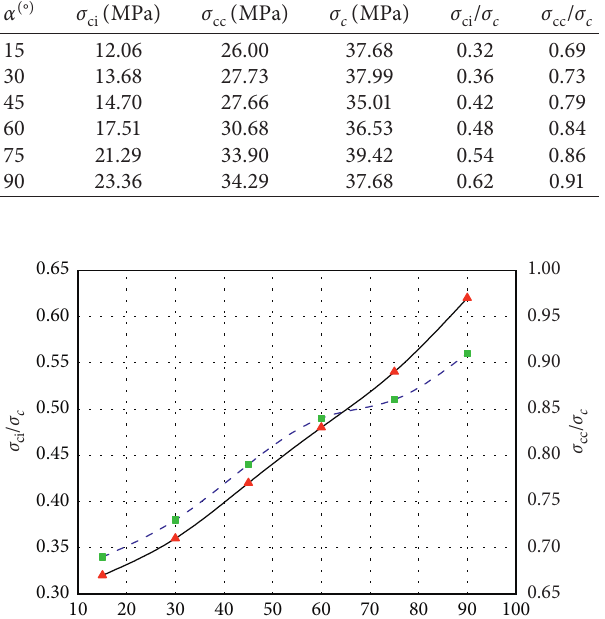
Figure 10: Stress-strain curves with different α . Table 5: σ / σ c and σ / σ c for different angles between the main flaw ci cc and axial load F . / σ c and σ / σ c ci cc